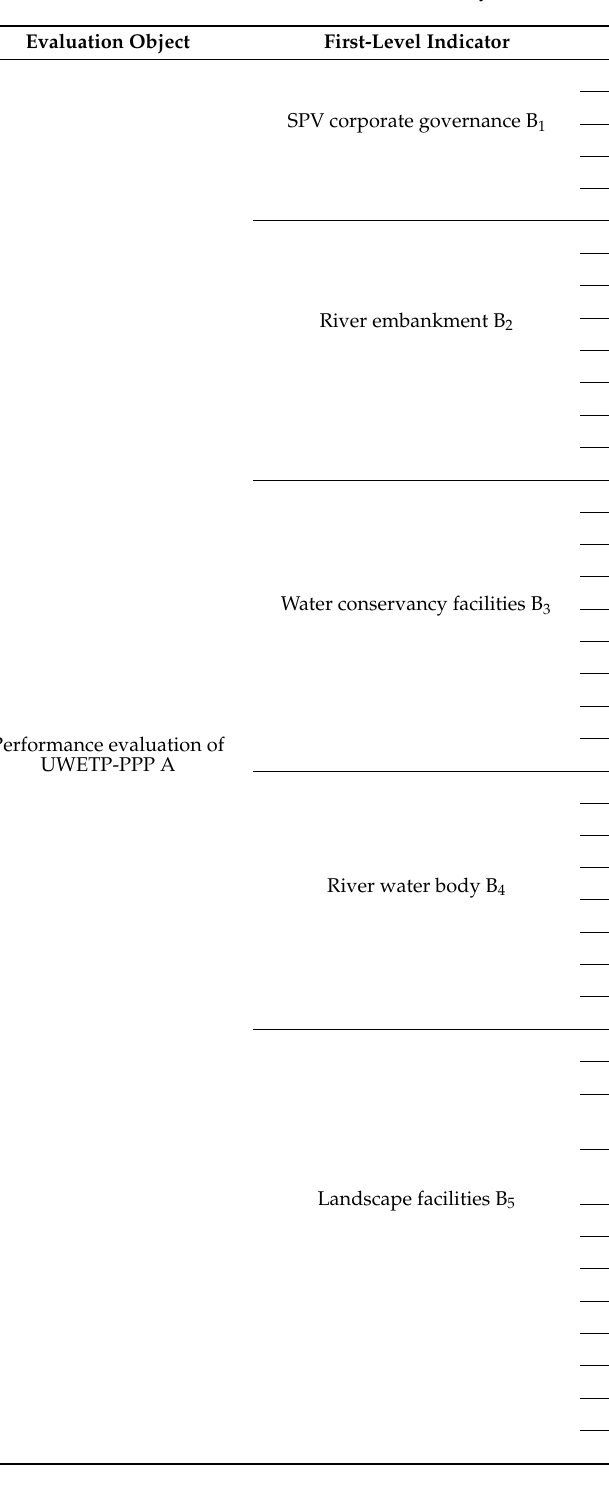
Table 1. Preliminary construction of indicator